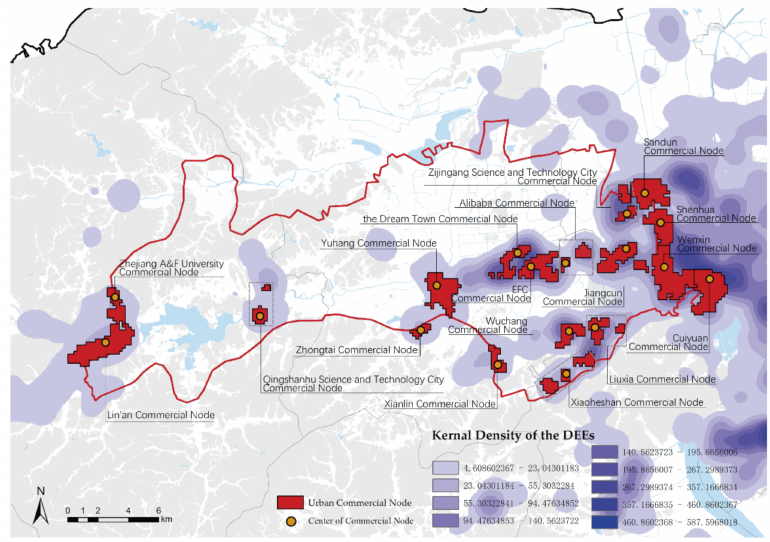
Figure 8. Spatial distribution of UCNs and agglomeration areas of